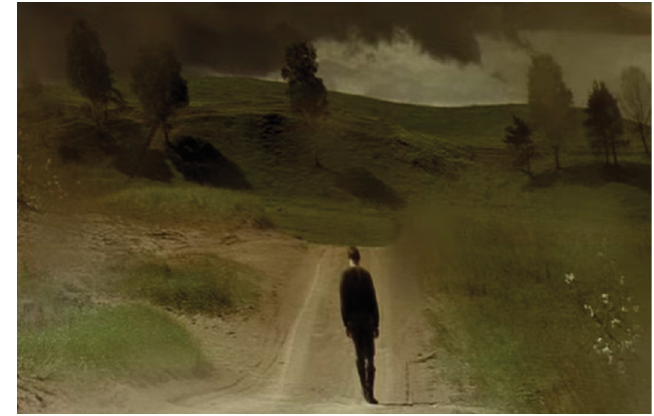
Figure 2 – Still from Mat i syn (1996), by Aleksandr